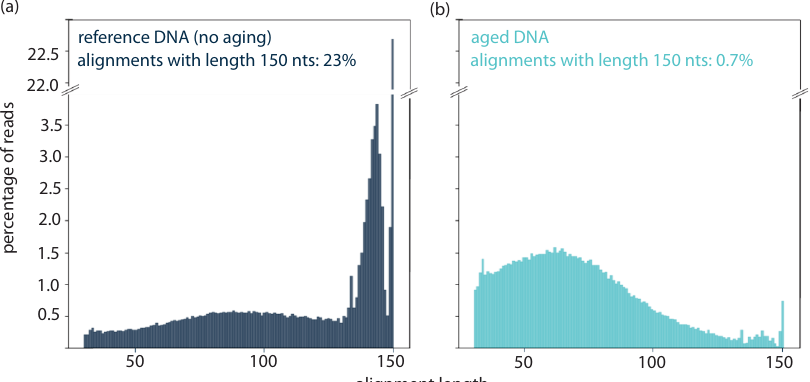
Fig. 2 Fragment length distribution analysis. Fragmentation of DNA fi le (originally containing 7373 unique DNA sequences of length 150 nt). Fragmentation analysis has been conducted by dsDNA denaturation, enzymatic single-strand library preparation and sequencing using Illumina ’ s iSeq100. Subsequently, alignment was performed to obtain the fragment length distribution, excluding sequences with <30 nt length. a Reference DNA that was not aged. b Sample aged at 30 °C for 6